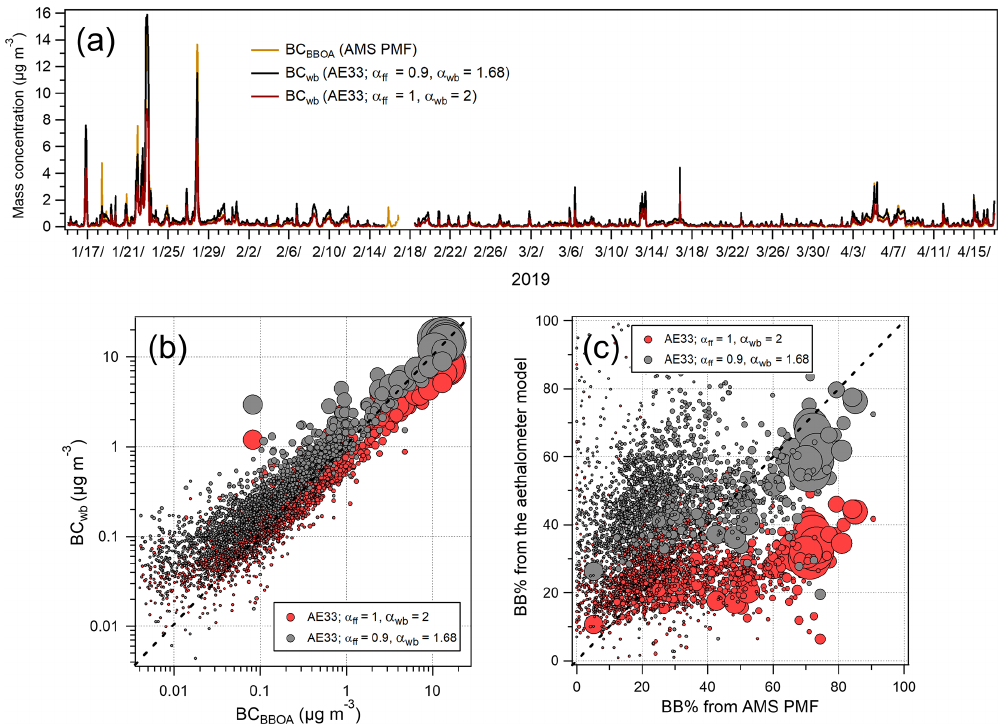
Figure 7. Comparison of AMS-PMF with the Aethalometer model source apportionment for BC at the residential site. Time series (a) , the scatter plot of BC wb and BC BBOA concentrations (b) , and BB% (c) . BC wb and BB% with the Aethalometer model were calculated by using α ff = 0 . 9 and α wb = 1 . 68 and α ff = 1 and α wb = 2. We used 1h time resolution. Marker size in (b) and (c) illustrates the concentration of total BC. The dotted line in (b) and (c) shows the 1 : 1